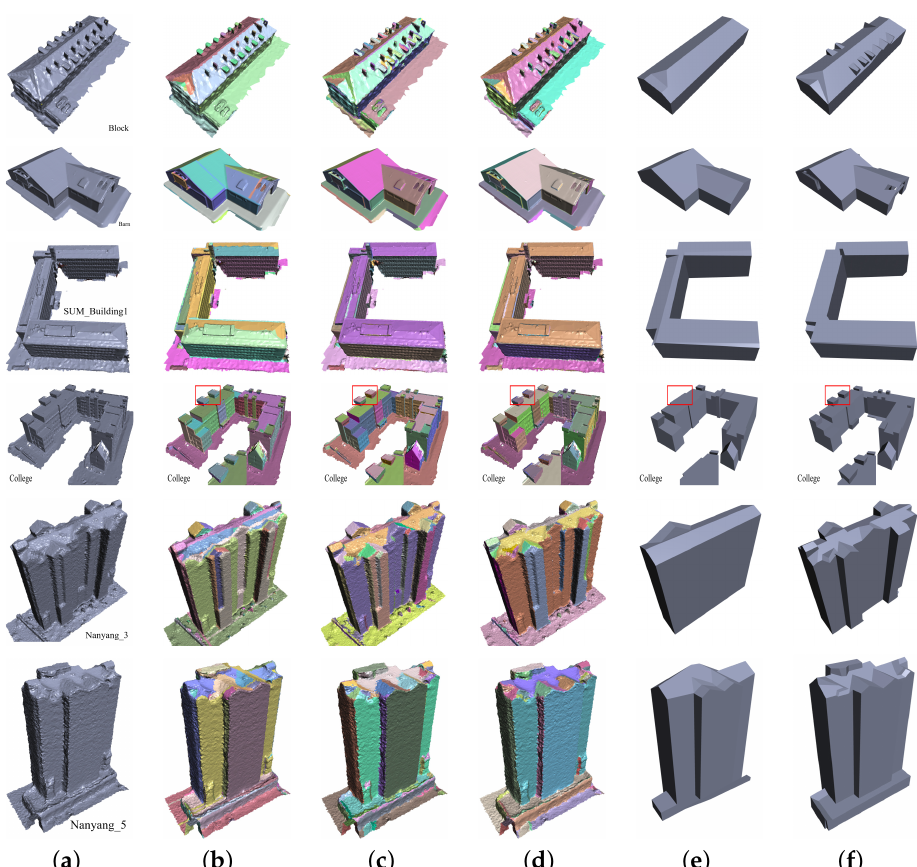
Figure 10. Comparison of segmentation and polyhedral models: ( a ) Original, ( b ) SABMP [11], ( c ) Unguided, ( d ) Our guided, ( e ) SABMP [11], and ( f )